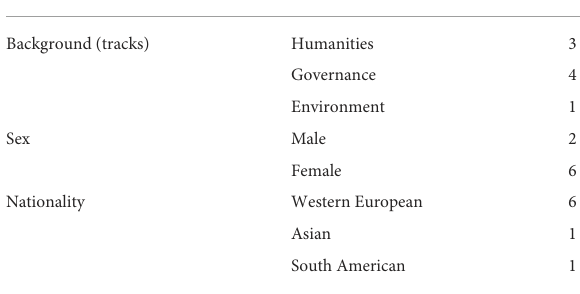
TABLE 1 Participants’ characteristics ( N = number of participants).